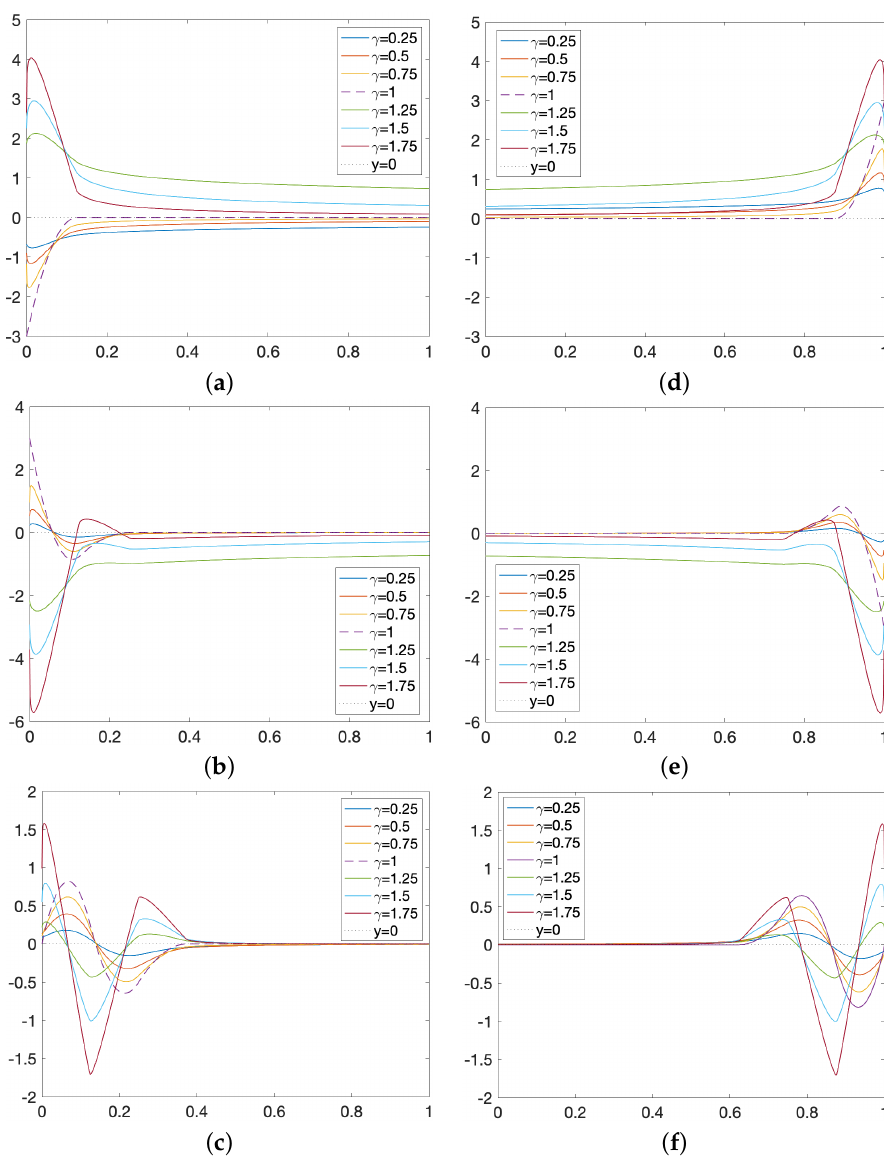
Figure 3. The Riesz–Caputo derivative of the left-edge functions (panels ( a – c )) and of the right-edge functions (panels ( d – f )) for different values of the fractional order γ , with 0 < γ <